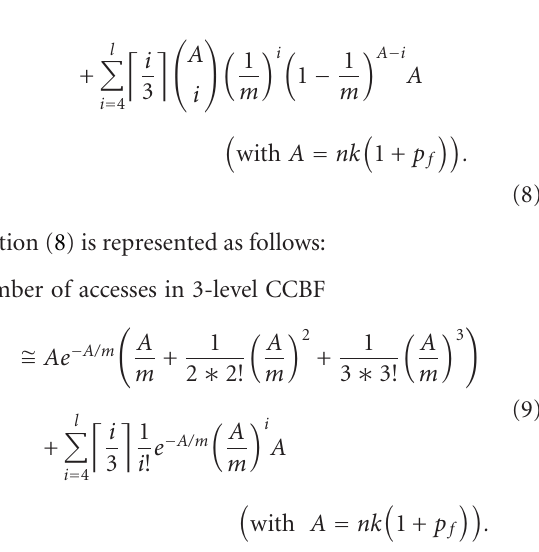
Figure 4: The l -level cached counting Bloom filter